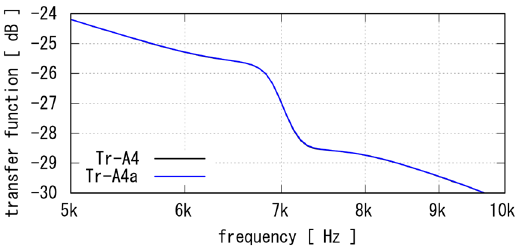
Figure 7. Effect of stabilizing winding on RBS (comparison between Tr-A4 and Tr-A4a).